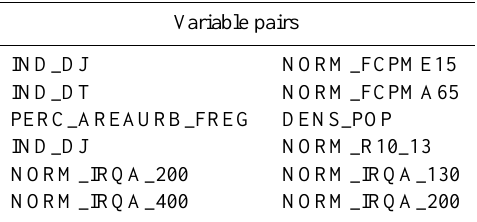
Table 4. Variable pairs with off-diagonal anti-image correlation ma- trix values>0.6. In grey are the excluded variables based on this criterion.